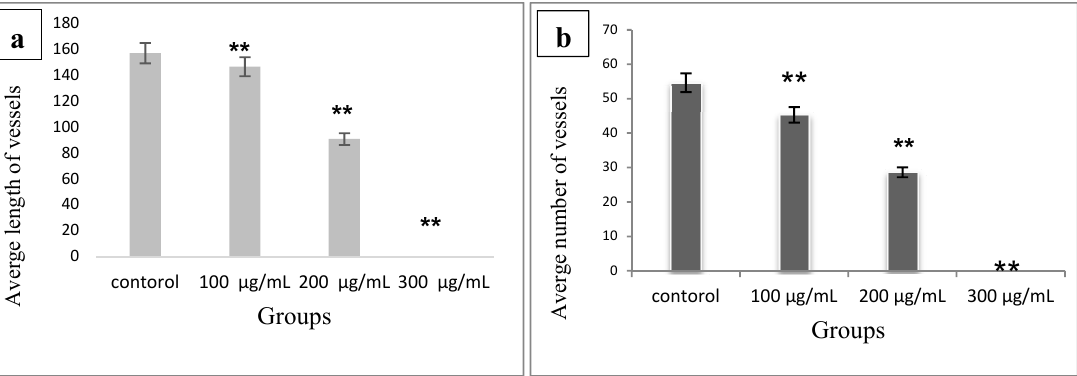
Figure 5. The effect of different concentrations of silver nanoparticles on length ( a ) and number ( b ) of small vessels in the aortic ring model ( ** p <